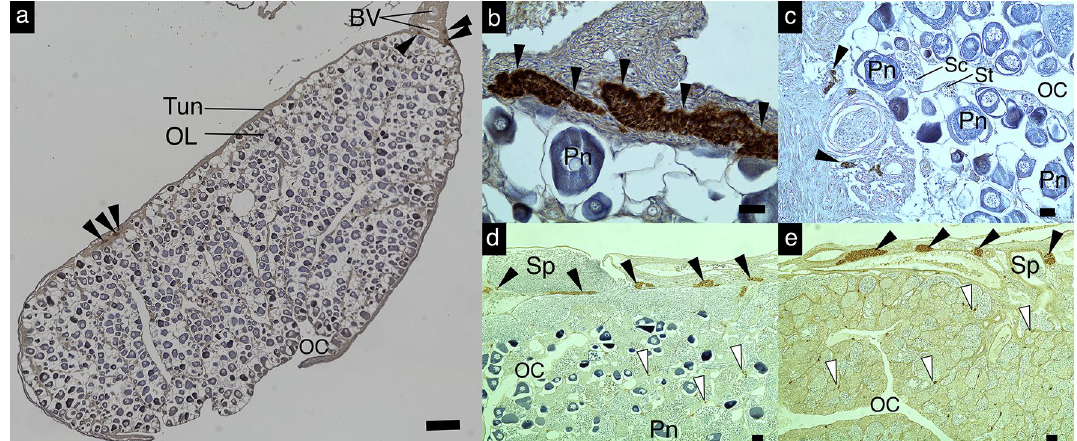
Figure 2. TIS cells showing immunoreactivity against Cyp11b in the tunica of the gonad of typical groupers. Immunoreactive cells against Cyp11b in the tunica of the ovary of Epinephelus akaara ( a ) low magnification and ( b ) high magnification, the early transitional gonad of E. awoara ( c ), the late transitional gonad of E. akaara ( d ), and the testis of E. fasciatus ( e ). Black and white arrow heads indicate TIS and Leydig cells, respectively. BV blood vessel, OC ovarian cavity, OL ovigerous lamellae, Tun tunica of the gonad, Pn perinucleolus stage oocyte, Sc spermatocyte, St spermatid, Sp sperm. Scale bars = 20 µm. The figures were constructed in Inkscape 1.0beta2 (https:// inksc ape.